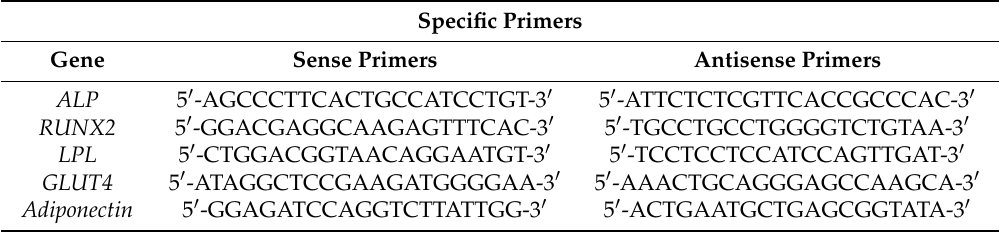
Table 3. Specific primers for ALP , RUNX2 , LPL, GLUT4 , and adiponectin.